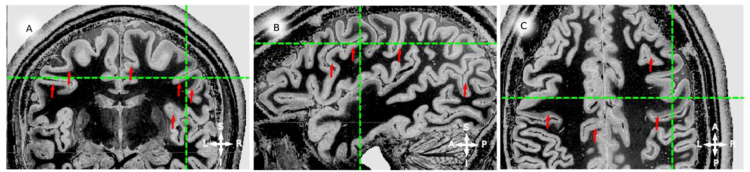
For the complete description see the caption of Fig. 4.